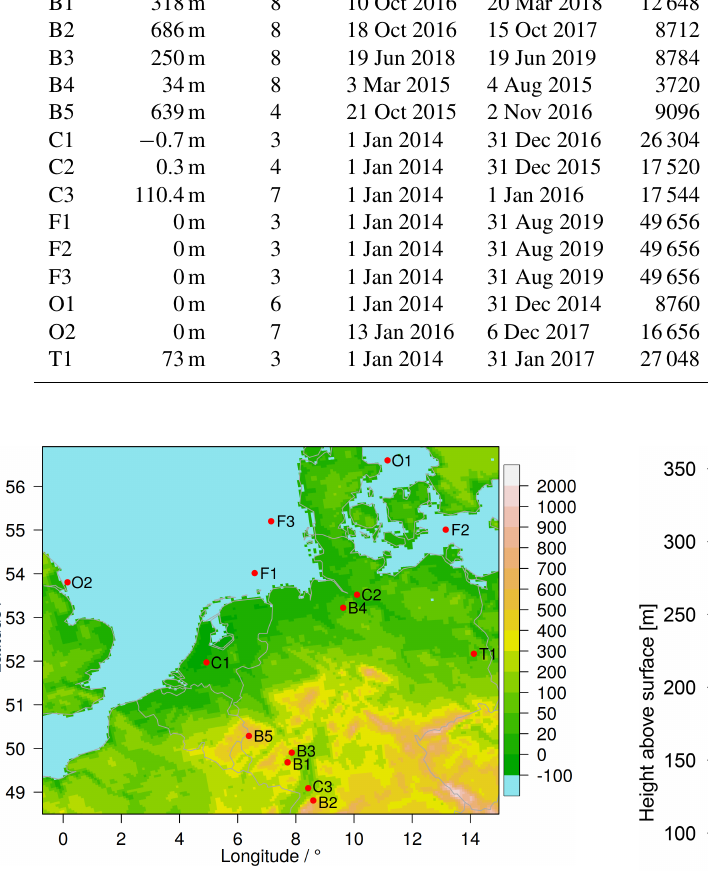
Figure 1. Measurement sites of BayWa r.e. (B1... B5), masts used in Frank et al. (2020b) (C1... C3), FINO (F1... F3), Orsted (O1, O2) and Tall Tower Dataset (T1). Colors in the back- ground show COSMO-REA6 topography.